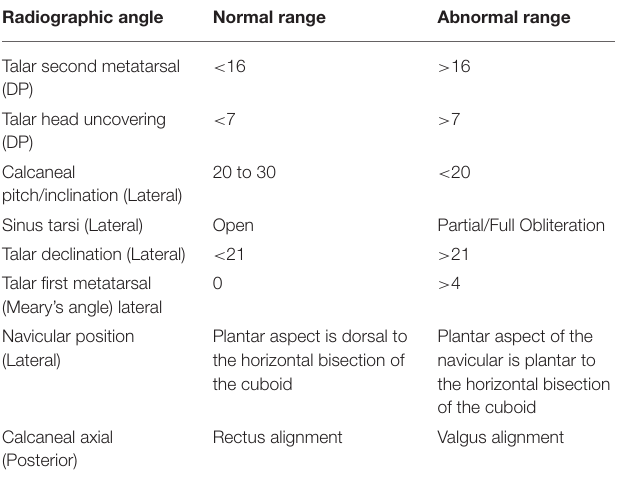
TABLE 1 | Comparison of normal to abnormal radiographic findings. Radiographic angle